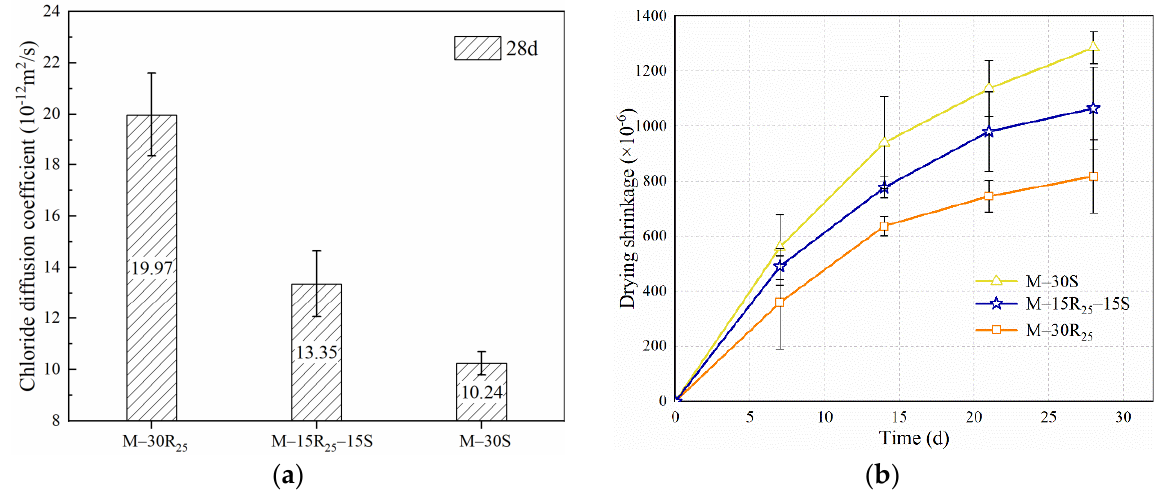
Figure 4. Durability results of eco-efficient mortar in Series A: ( a ) chloride diffusion coefficient ( D RCM ) and ( b ) drying shrinkage.